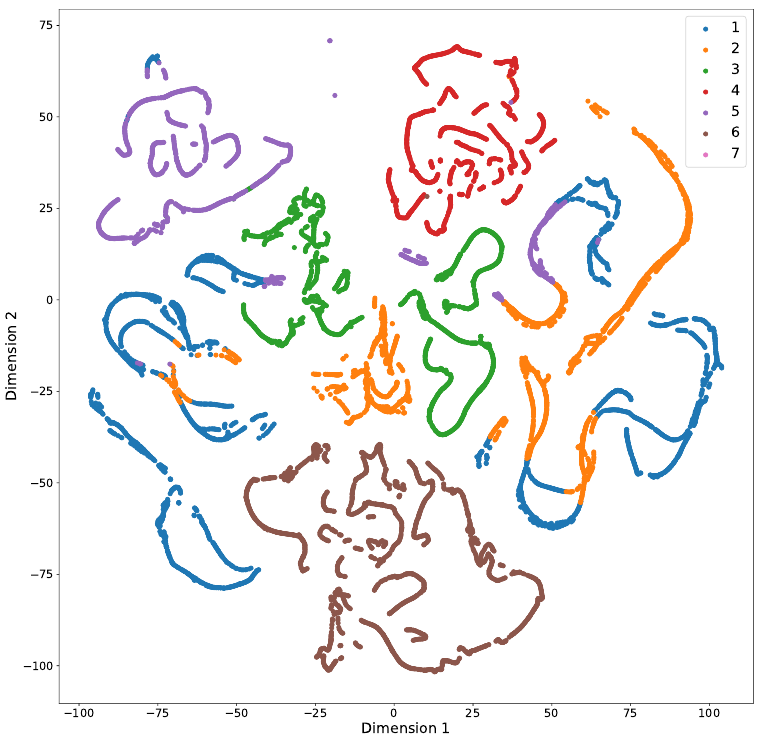
Figure 9. Two-dimensional representation of the embedding using t-SNE and color according to each situation. The number assigned to each color corresponds to the driving situation. Table 4. Dataset division according to each driving